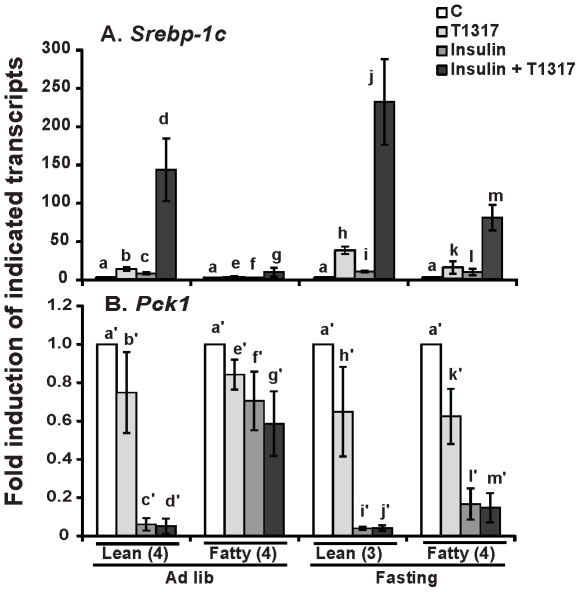
The mRNA levels of Srebp-1c (A) and Pck1 (B) in response to insulin, T1317 and insulin+T1317 treatments in hepatocytes from ZL or ZF rats in ad libitum or after fasting for overnight.Primary hepatocytes from rats on different feeding conditions were isolated and pre-treated as described in Materials and Methods. Hepatocytes were incubated in medium A without or with 1 µM T1317 in the absence or presence of 1 nM insulin for 6 hours. Total RNA was extracted and subjected to real-time PCR analysis. The expression level of the indicated transcripts in the control hepatocytes from lean or fatty rats in ad lib or overnight fasting was arbitrarily assigned a value of one for its corresponding cell type and feeding condition. Results were plotted as fold induction and presented as means ± SD of indicated numbers (in parenthesis after animal) of independent hepatocyte isolations for both lean and fatty rats (for Srebp-1c: d>b>c>a, g>a/f, j>h>i>a, and m>k/l>a, b>e, c>f, d>g, h>b, h>k, j>m, k>e, l>f, and m>g, using one-way ANOVA; for Pck1: a′/b′>c′/d′, a′/h′>i′/j′, a′/k′>l′/m′, f′>c′, g′>d′, f′>l′, and g′>m′, using one-way ANOVA; all P<0.05).